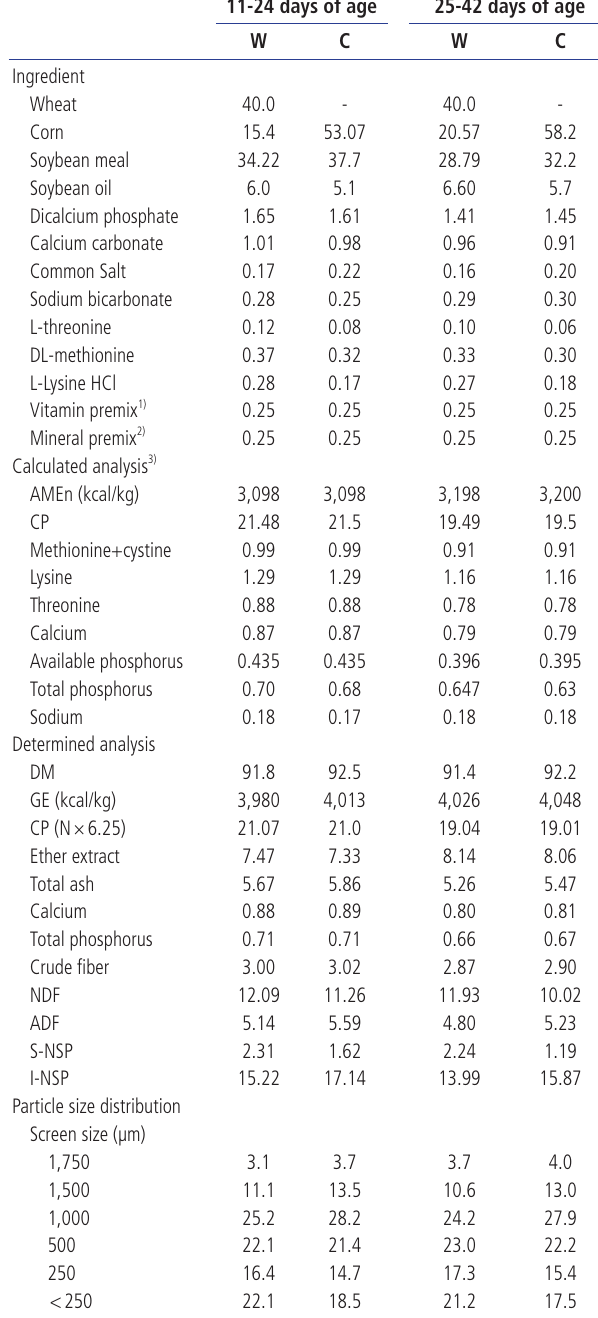
Table 1. Ingredient composition, nutrient content and particle size distribution of the experimental diets (%, as-fed basis, unless otherwise